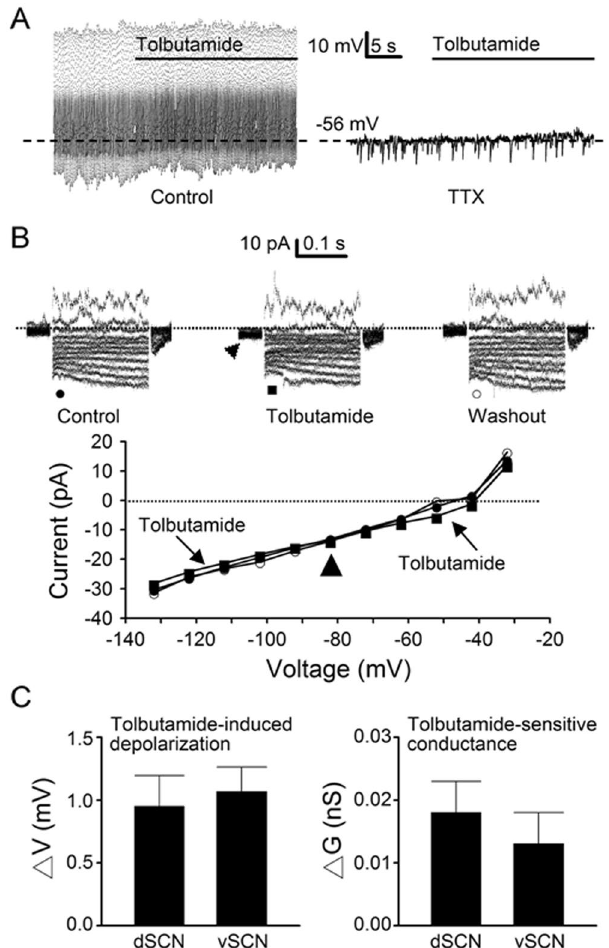
Figure 4. Tolbutamide effects on membrane potential and conductance with perforated patch recordings. ( A ) A representative dSCN neurone showing the effects of tolbutamide on spontaneous firing (left panel) and membrane potential (right panel) after the addition of TTX to block action potentials. Note the weak depolarisation by tolbutamide. Daytime recordings (ZT 7). ( B ) A representative dSCN neurone showing the reversible effects of tolbutamide on the membrane current (top panels) and the I-V relations (bottom panel). Note the small inward current induced by tolbutamide at a holding potential of − 52 mV (marked by arrowhead). Nighttime recordings (ZT 13). ( C ) Summary of tolbutamide-induced depolarisation (left panel) and tolbutamide-sensitive conductance (right panel). Baseline resting potential: dSCN ( − 56 ± 1 mV; n = 39), vSCN ( − 56 ± 1 mV; n = 39). Baseline resting conductance: dSCN (0.38 ± 0.05 nS; n = 17), vSCN (0.31 ± 0.04 nS; n = 17). Dotted lines are zero current